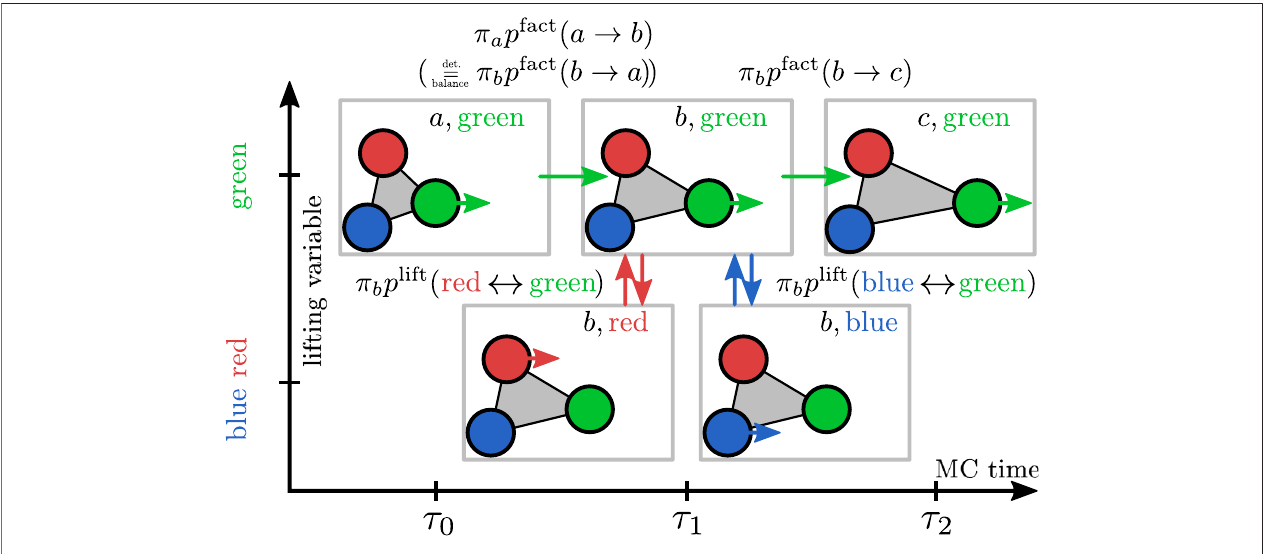
FIGURE 5 | Conditional lifting in a system with three-particle interaction. The conditional lifting probabilities can be derived from the balance condition. Analogously to Figure2 (i.e.,using Eq.5 anddividingby π b )anddecomposingtheliftingprobabilitiesaccordingto Eq.15 andchoosing λ red → green ≡ λ green ,weget [− d E green ] + (cid:2) [ d E red ] + λ green + [ d E ] + λ fl owing probability fl uxes, leading to λ blue green from the in